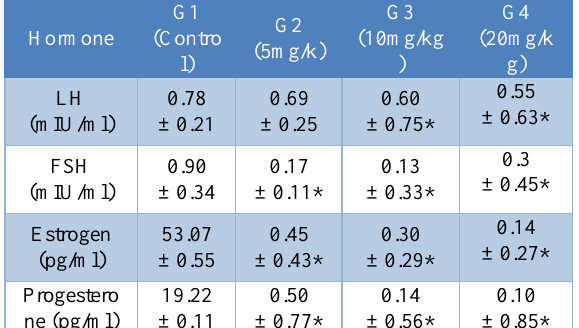
Table, 1: Mean values of FSH, LH, estrogen and progesterone levels following administration of Azorubine on day 30.